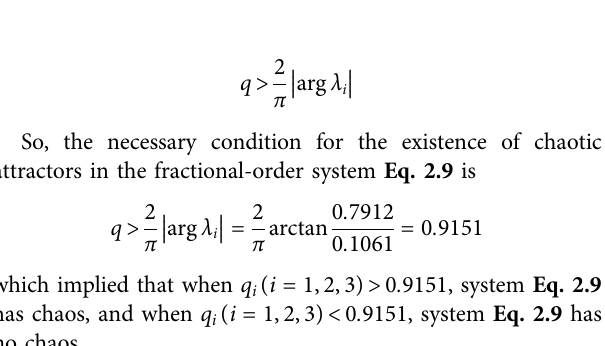
FIGURE 2 | Phase portraits of model Eq. 2.9 with q i ( i (cid:1) 1 , 2 , 3 ) (cid:1) α